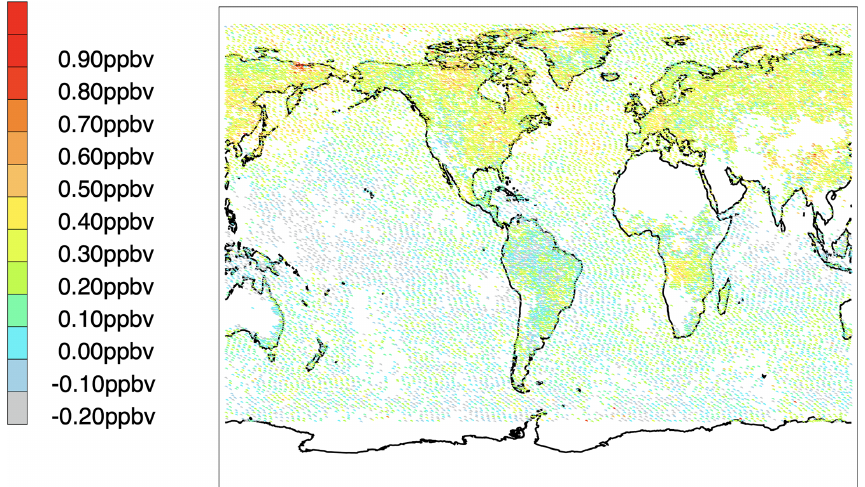
Figure 5. CrIS PAN for 1 August 2020 (subsampled by selecting the centermost CrIS FOV in each 0 . 8 ◦ × 0 . 8 ◦ grid box for latitudes above 70 ◦ S). Note that gray includes points where the CrIS PAN is below − 0 .